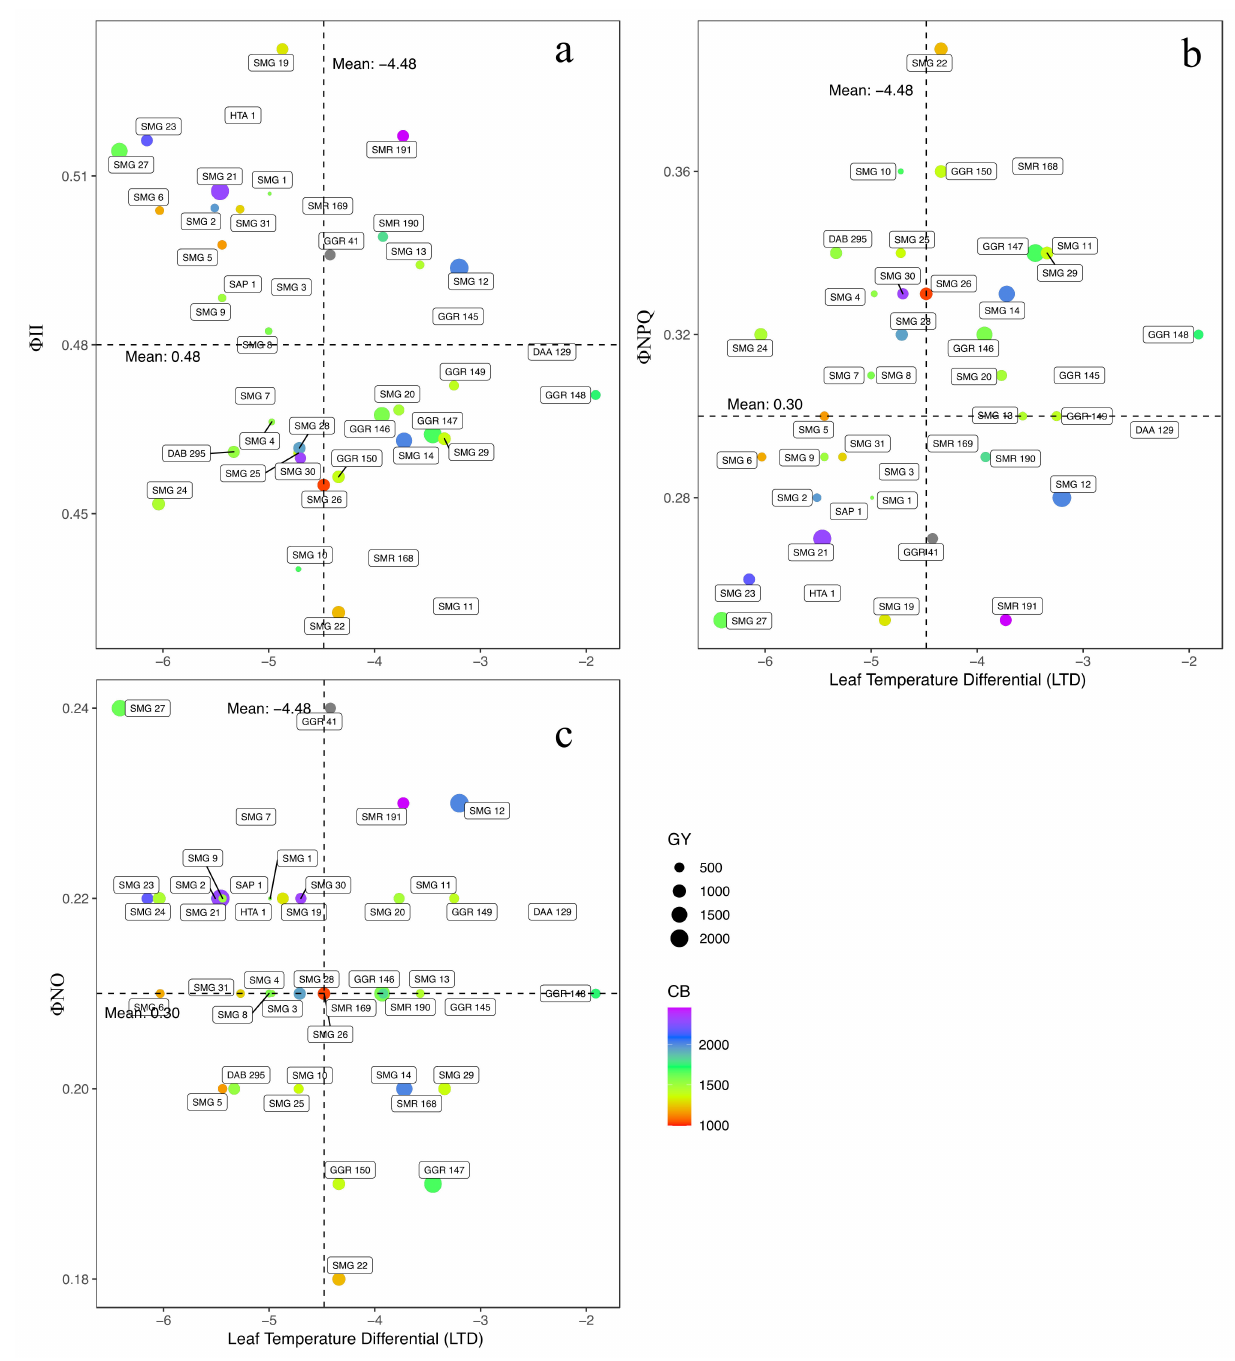
Figure 4. Relationship between different energy pathways and Leaf Temperature Differential (LTD) as a function of the gradient of non-photochemical quenching CB (change in the colour of violet and red as greater to lesser value) and magnitude of non-regulated processes GY (size of the circle), parameters that affect the response variable. ( a ) Quantum yield of photosystem II ( Φ II) and LTD; ( b ) Quantum yield of regulated non-photochemical energy loss in PSII ( Φ NPQ) and LTD; ( c ) Quantum yield of regulated non-photochemical energy loss in PSII ( Φ NPQ) and LTD. The dotted lines on the axes correspond to the means of the dependent and independent